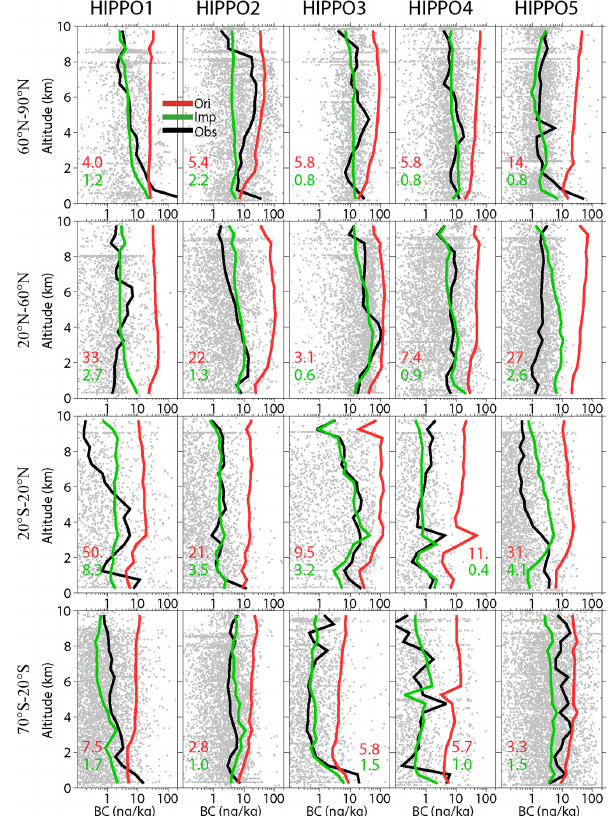
Figure 4. Vertical profiles of simulated and observed BC mass mixing ratios over 0.5km altitude bins along the flight tracks of HIPPO 1–5 over the central Pacific Ocean (130 ◦ W–160 ◦ E). Data are shown separately as averaged over 70–20 ◦ S, 20 ◦ S–20 ◦ N, 20– 60 ◦ N, and 60–90 ◦ N. The black, red, and green lines are mean val- ues of BC mixing ratios from observations, default, and improved models, respectively. The gray dots represent measured BC concen- trations. The green (red) number indicates the averaged MNAE for the improved (original) model (see Eq. 3).